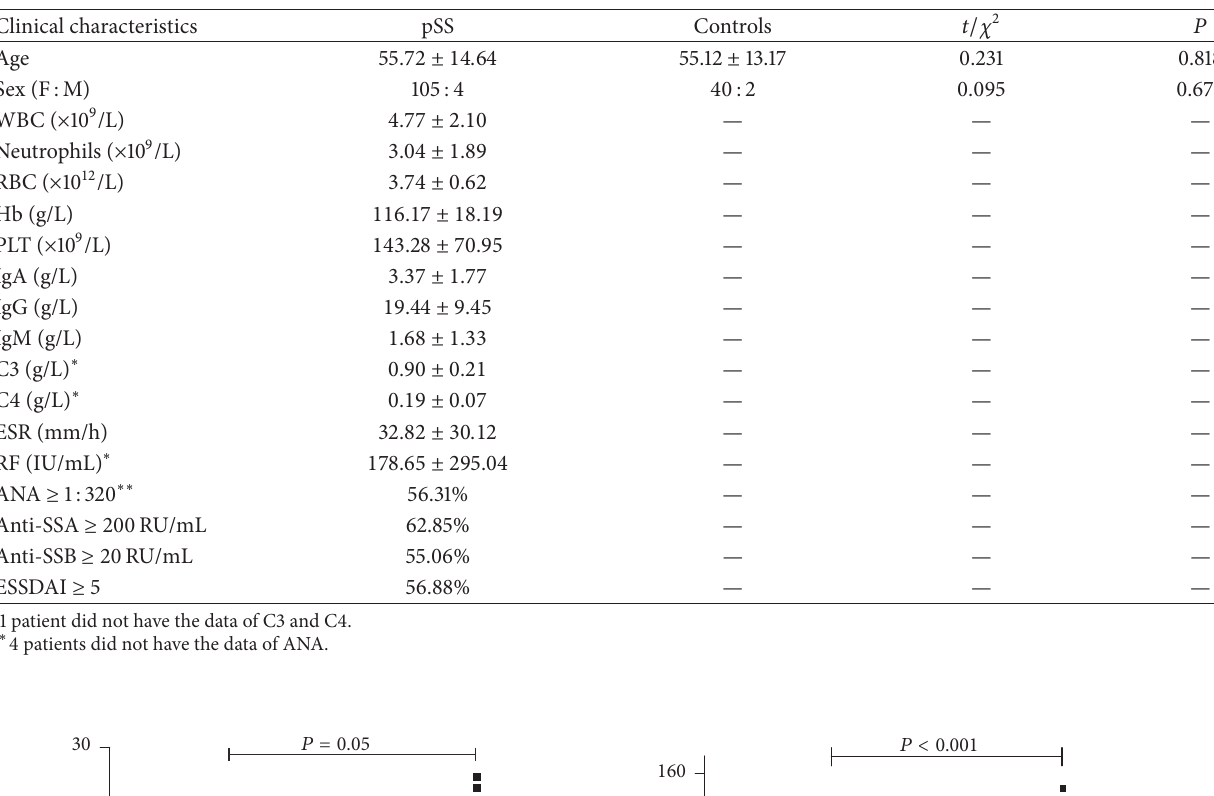
Table 1: Characteristics of the studied 109 pSS patients and 42 healthy controls.